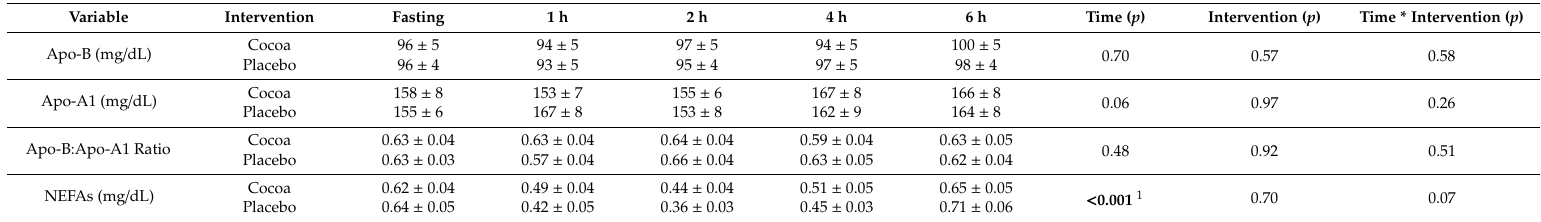
Table 1. Postprandial serum levels of apolipoproteins and non-esterified fatty acids in adults with type 2 diabetes following a high-fat meal challenge with polyphenol-rich cocoa or placebo